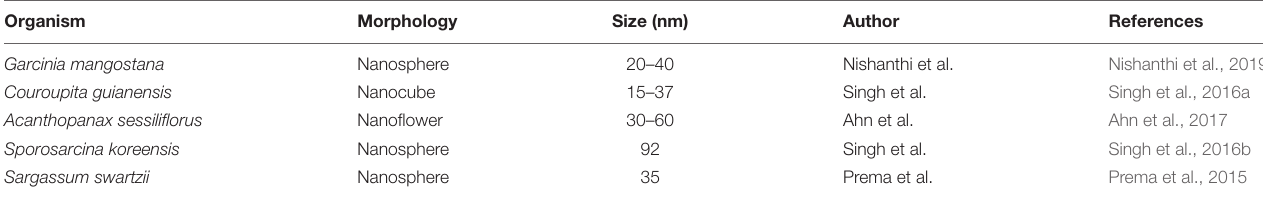
TABLE 2 | Organisms mediated synthesis of AuNPs with different morphology and size.